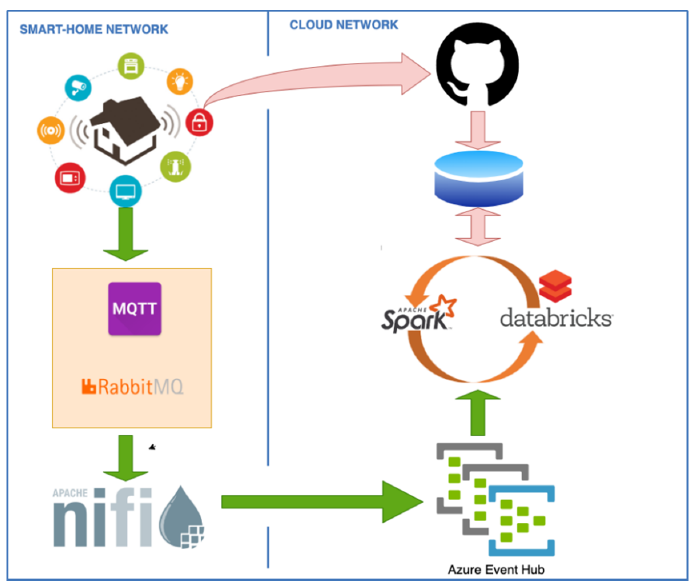
Figure 9. Interactions among a smart home and Azure Databricks.